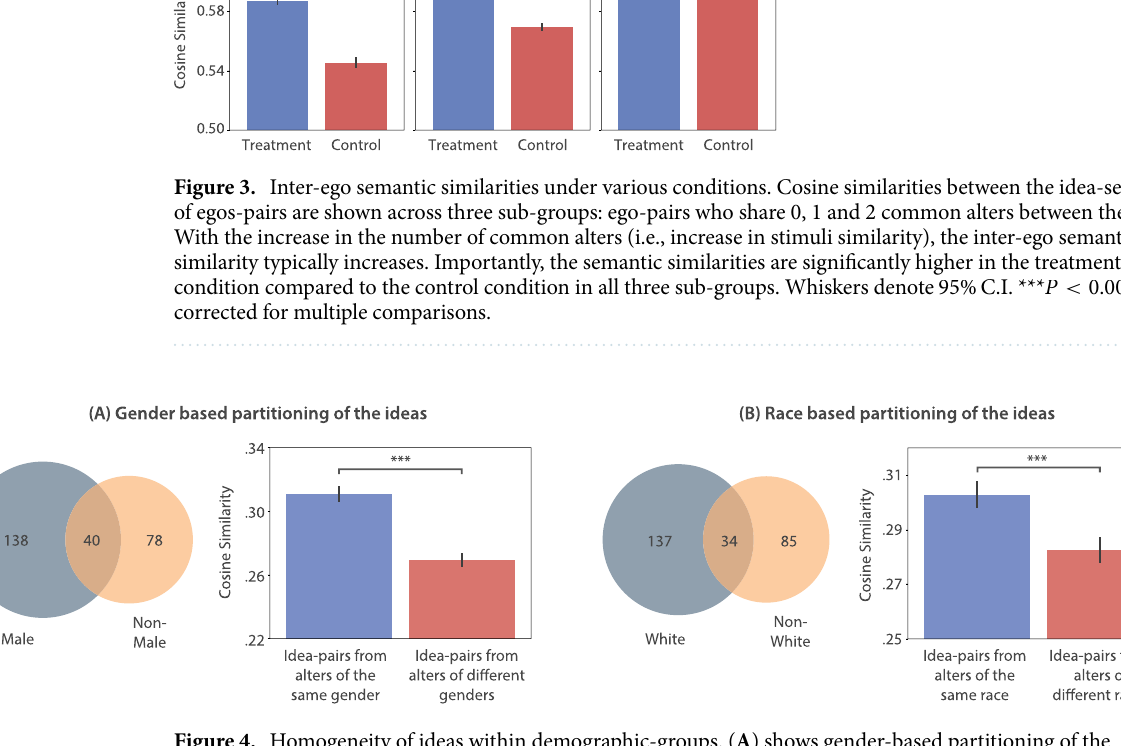
Figure 4. Homogeneity of ideas within demographic-groups. ( A ) shows gender-based partitioning of the alters’ ideas. Some of the ideas were submitted by both male and non-male alters, while others were submitted uniquely by either gender categories. We only consider ideas from the latter case in the similarity analysis. Pairwise comparisons of ideas within gender show a significantly higher similarity than idea-pairs between genders. ( B ) shows the same insights in case of race-based partitioning of the alters’ ideas. Whiskers denote 95% C.I. *** P < 0.0001